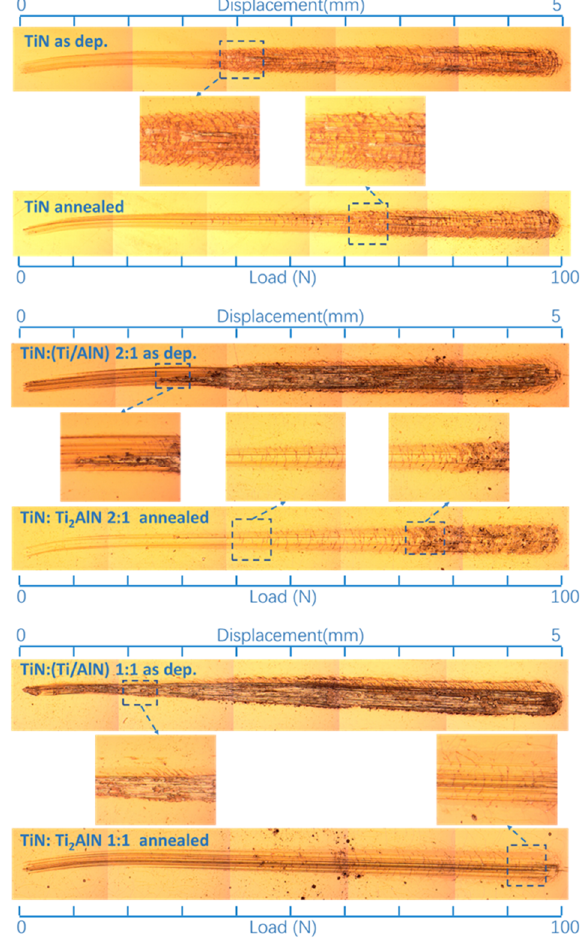
Figure 5. Scratch topographies of the TiN/(Ti/AlN) and TiN/Ti 2 AlN multilayers.